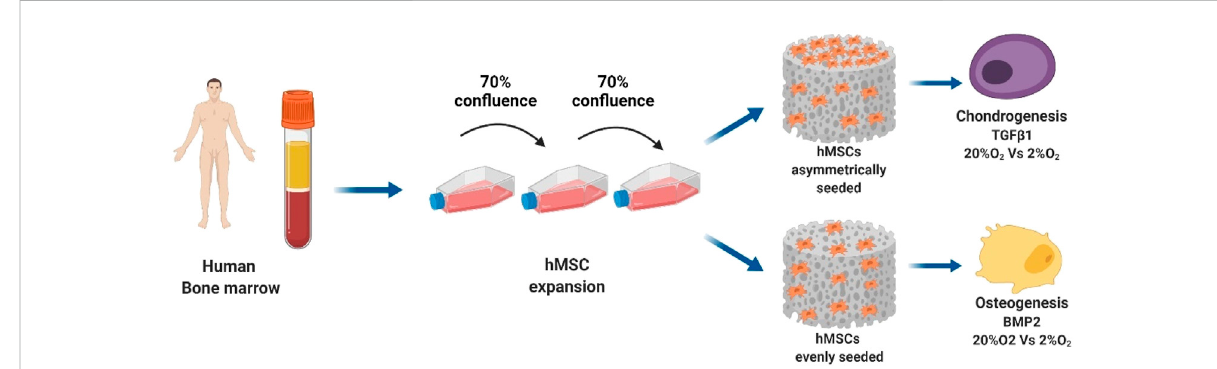
FIGURE 1 The bone TE paradigm. Scaffold, stem cells, and bioreactor culture systems enable the growth of grafts in vitro for bone and cartilage repair applications in vivo (Monaco et al.,